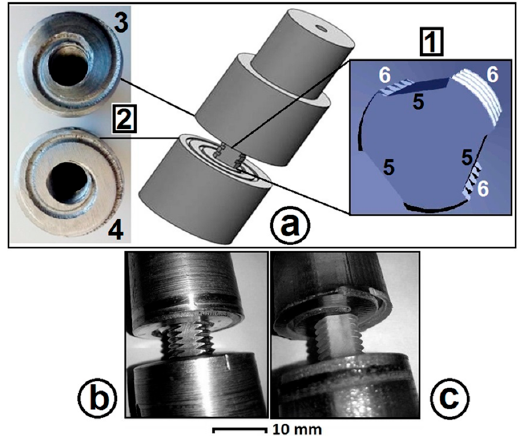
Figure 1. Schematic of the Bobbin Tool employed in experimental tests, ( a ) 3D model of the bobbin tool; (1) pin, (2) open end scrolls, (3) top shoulder, (4)bottom shoulder, (5) flats, (6) threads; ( b ) H13 tool